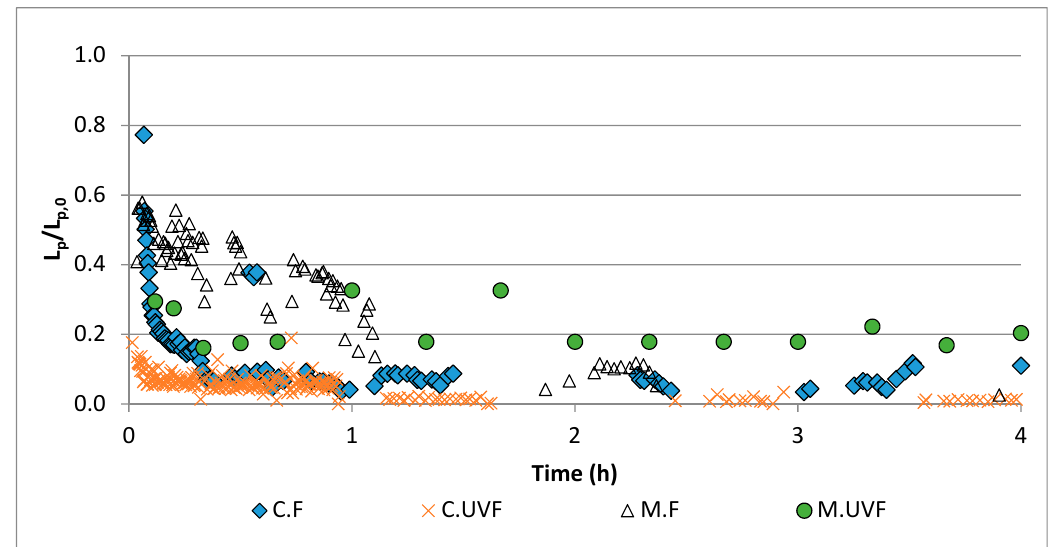
Figure 3. Variation of the normalized permeability of the membranes in the four filtration tests.